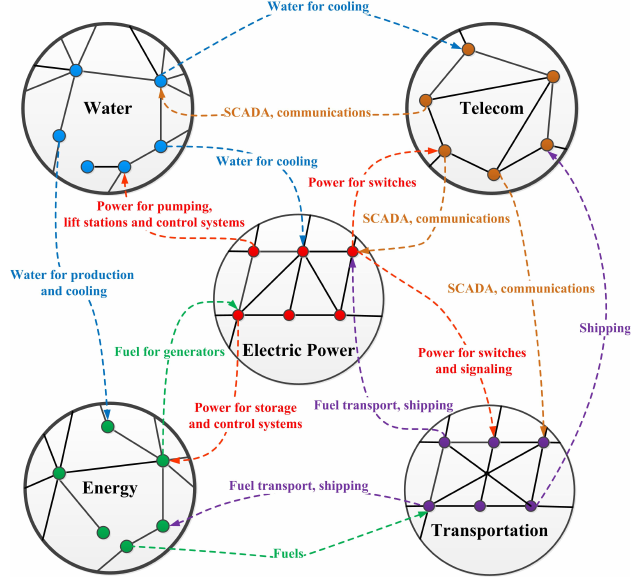
Figure 1. (Color online) Illustration of the interdependent relationship among different infrastructures [54]. These complex relationships are characterized by multiple connections between infrastructures, feed-back and feed-forward paths and intricate, branching topologies. The connections create an intricate web that can transmit shocks across multiple infrastructures. [54].This figure is from Ref.